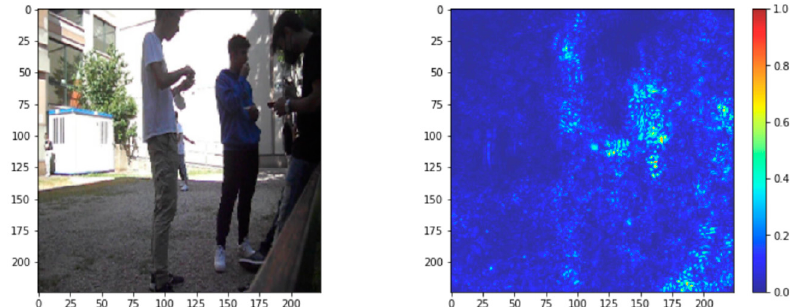
Figure 15. Original DSB image analysis using attribution, also known as a saliency map [38]. It is a technique to rank the pixels that highlight the areas of the given image, discriminating the zones using colors. Cyan shows the areas used to compute: the student in the middle and the other two classmates on the right contribute more to detection.